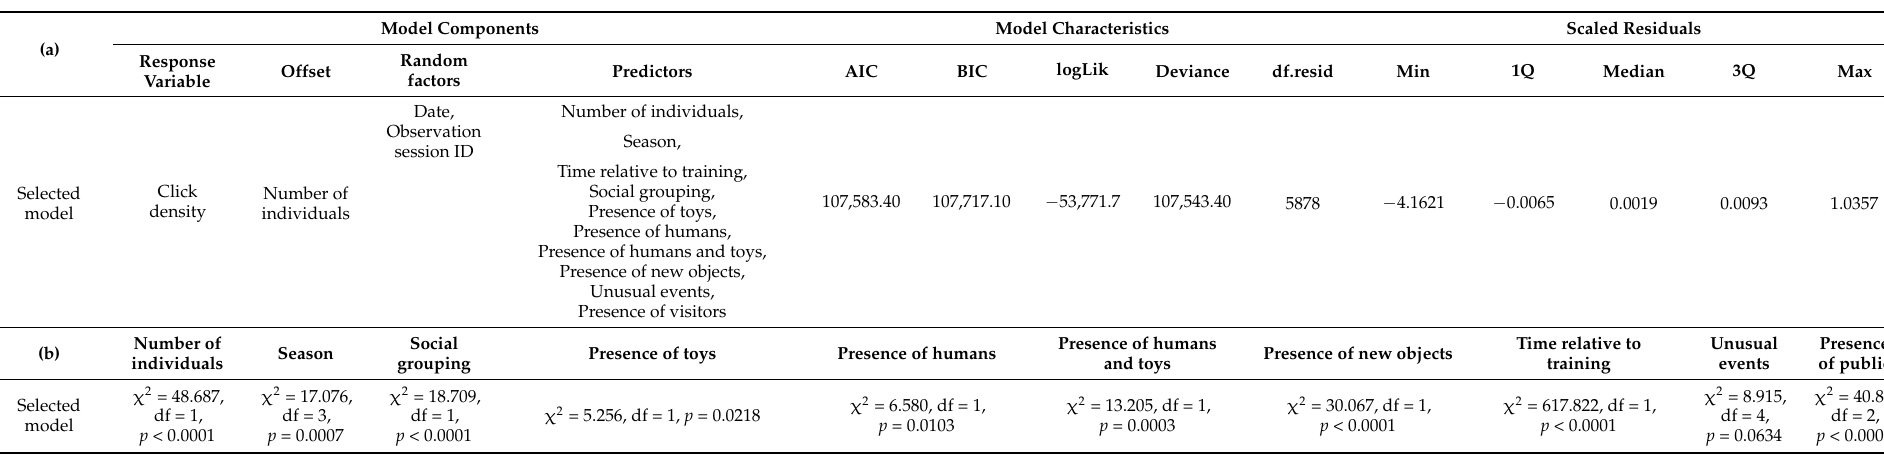
Table 3. Model characteristics (a) and statistical outputs (b) from the generalized linear mixed-effects